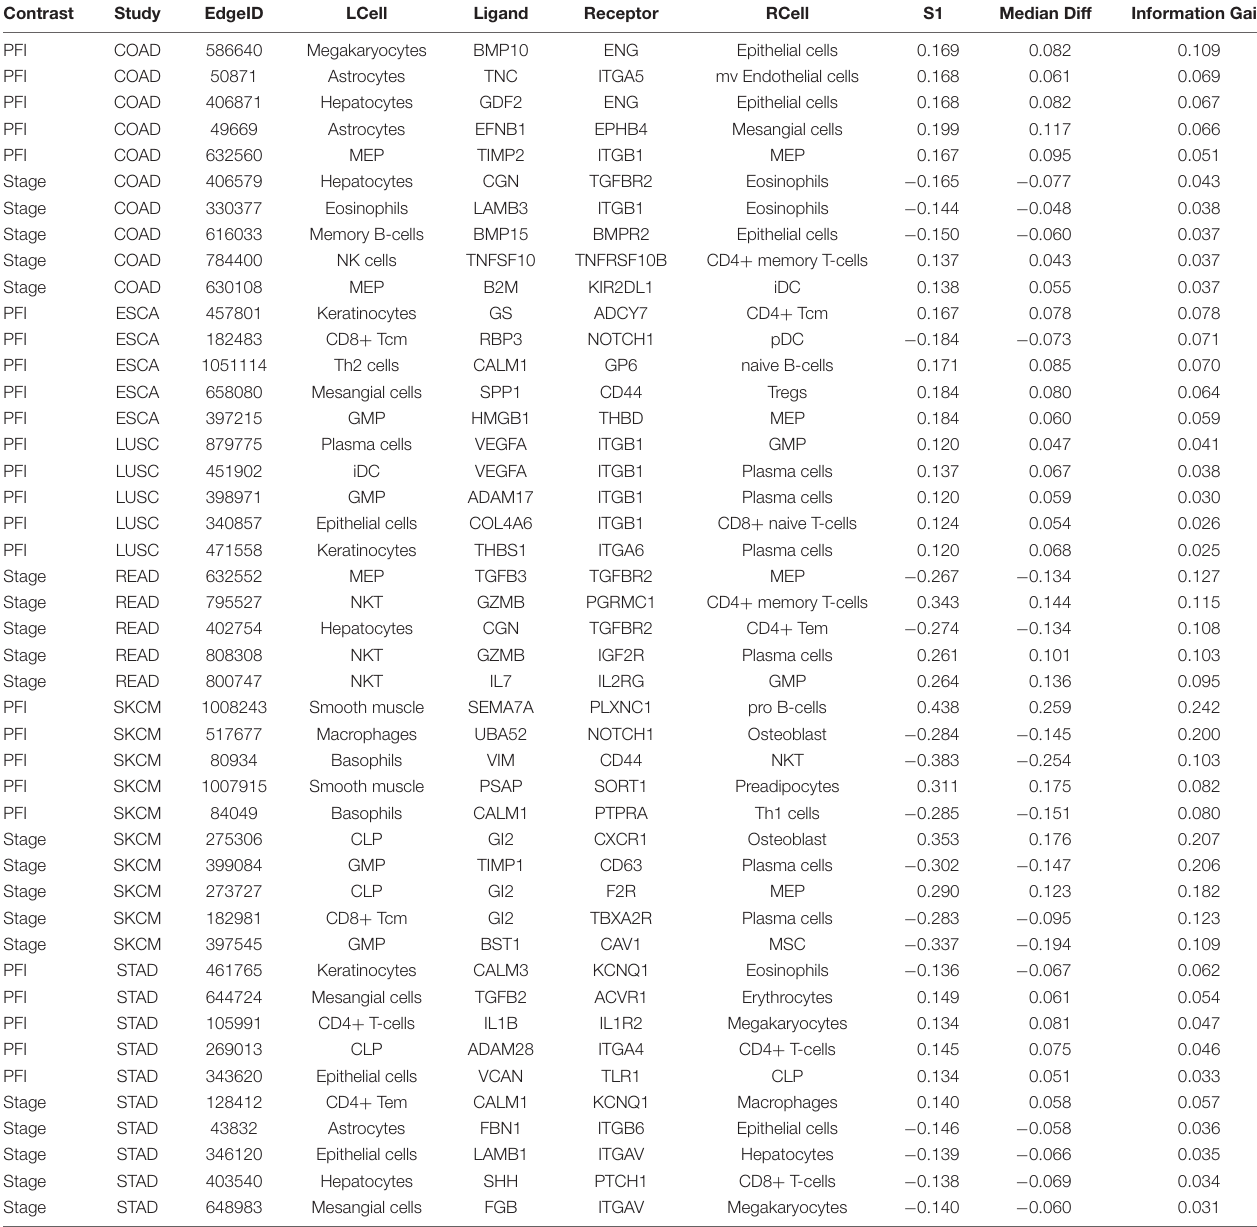
TABLE 2 | Top five most predictive edges from XGBoost